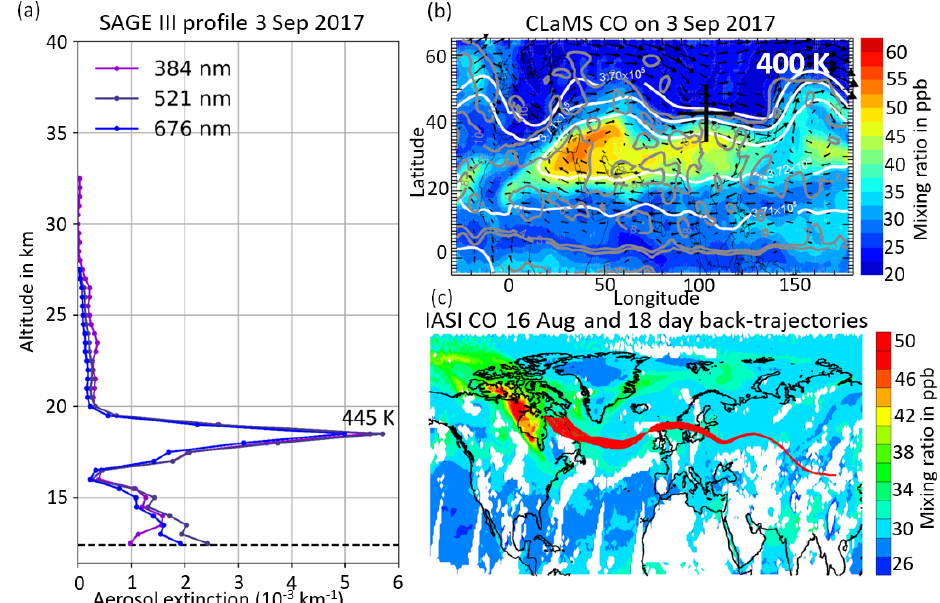
Figure B2. Same as for Fig. 5 and B1 for 3 September 2017 at 42.94 ◦ N and 103.8 ◦ E. (a) The dotted black line represents the given tropopause height by the SAGE III data set. (b) CLaMS CO map at 400K on 3 September 2017. (c) IASI CO map, integrated over 12h at 85.18hPa 18d before the SAGE III profile measurement in (a) . Superimposed: every fifth of the 1000 18d TRACZILLA kinematic back-trajectories initialized at the geographical position and altitude of the fire plume peak in (a) .